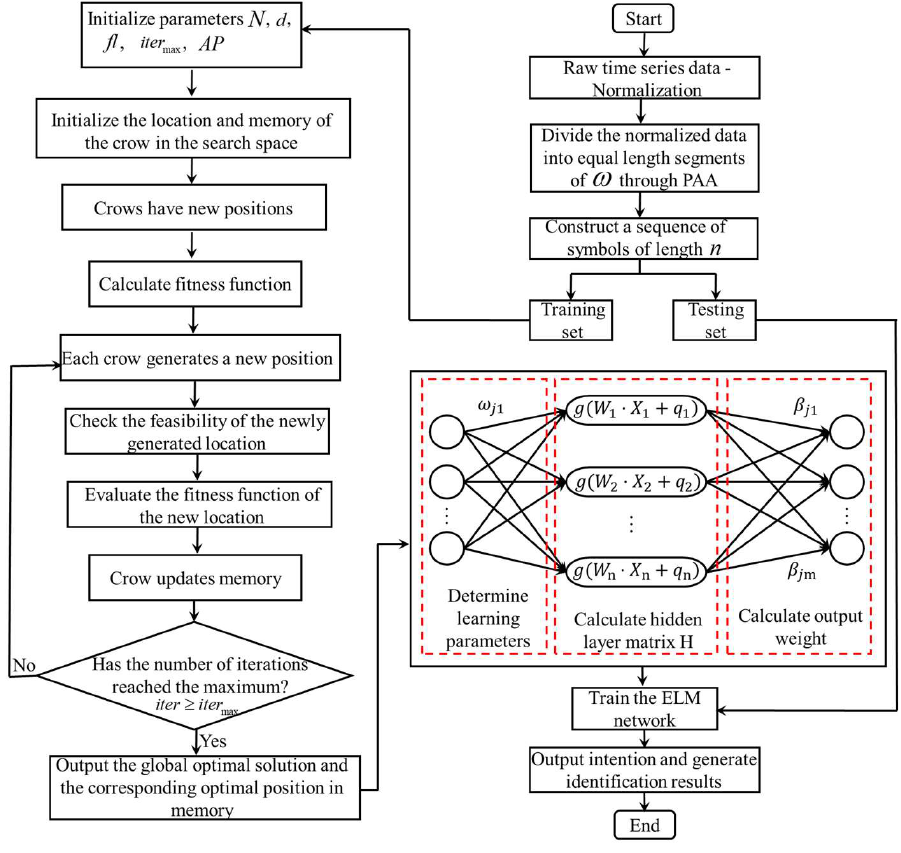
Figure 5. The flow diagram of ESAX-CAS-ELM.